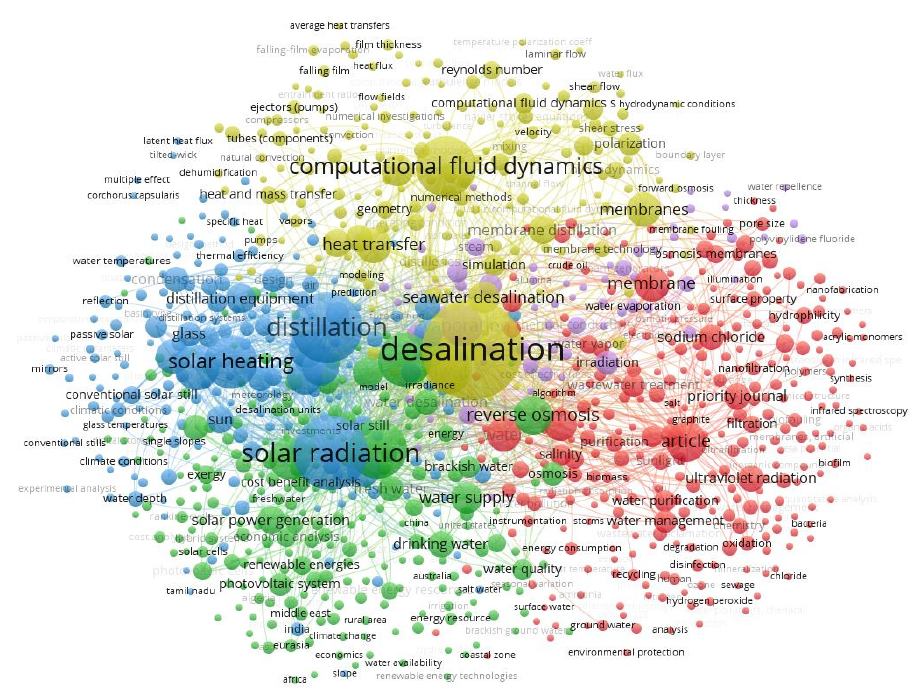
Figure 4. Network analysis diagram based on indexed keywords.